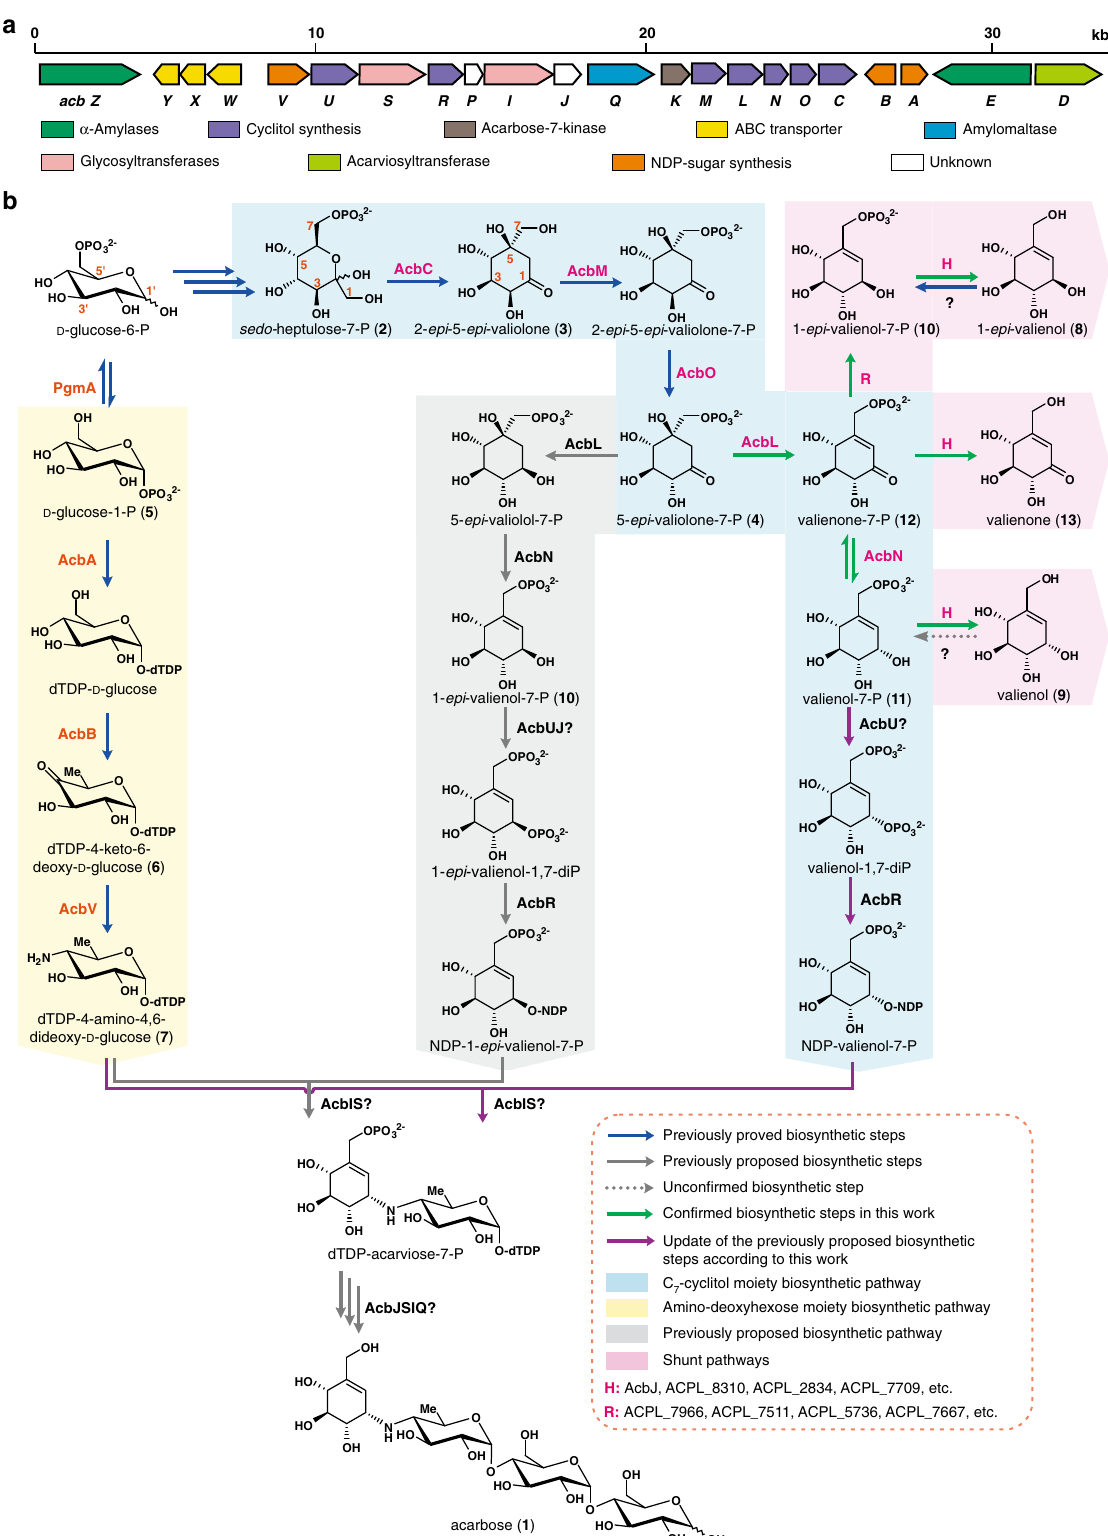
Fig. 1 The biosynthesis of acarbose in Actinoplanes species. a The biosynthetic gene cluster of acarbose ( 1 ) ( acb cluster, GenBank accession no. Y18523.4). b The biosynthetic pathway to 1 , including previously determined biosynthetic steps (blue arrow), possible conversion without experimental con fi rmation (gray dashed arrow), previously proposed biosynthetic steps (gray arrow), con fi rmed biosynthetic steps in this work (green arrow), and update of the previously proposed biosynthetic steps according to this work (purple arrow). The biosynthetic pathways to the C 7 -cyclitol moiety, the amino-deoxyhexose moiety, and the shunt products are highlighted in blue, yellow, and plum, respectively, and the previously proposed biosynthetic pathway to the C 7 -cyclitol moiety is highlighted in